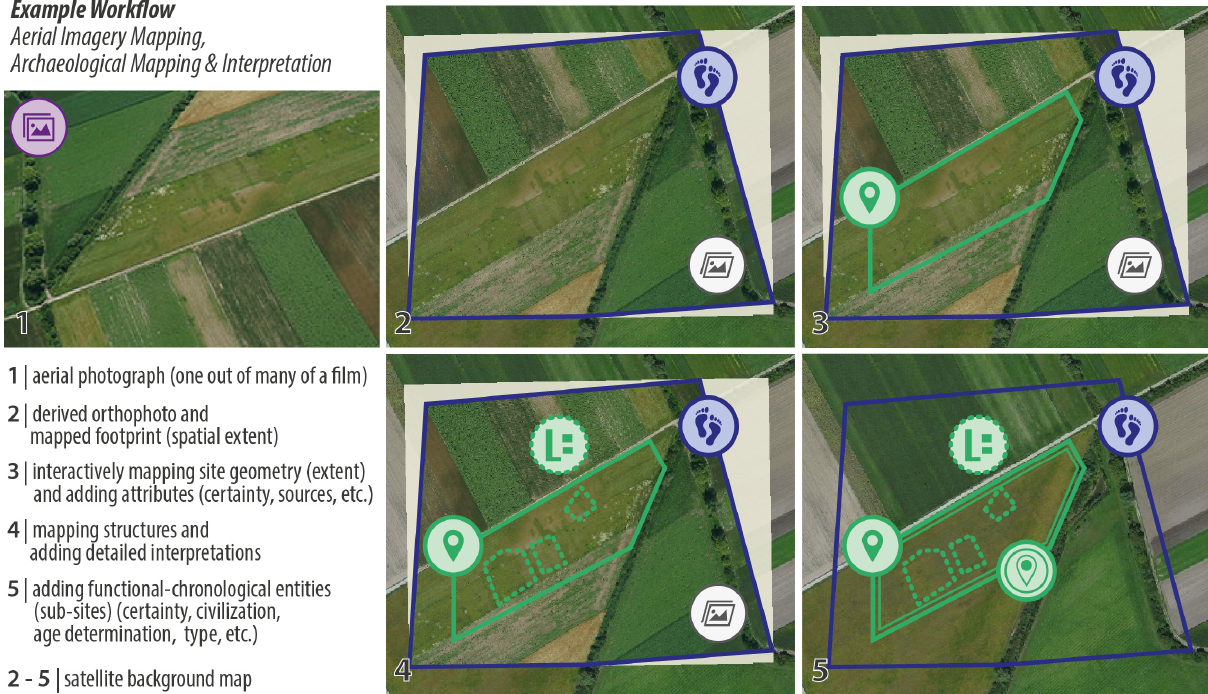
Figure 4: APIS example workflow for aerial imagery mapping and archaeological mapping and interpretation.